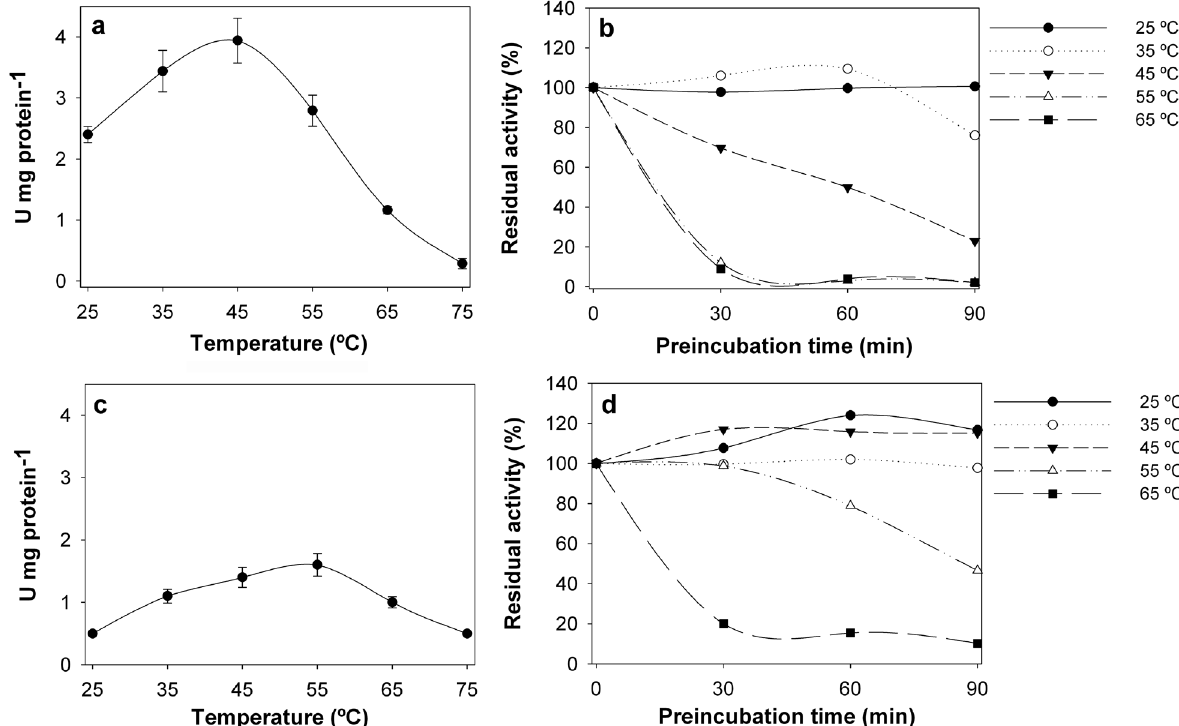
Fig. 2. Temperature effect on digestive proteases of juvenile of sheepshead Archosargus probatocephalus : (a) optimal tem- perature of acidic proteases, (b) temperature stability of acidic proteases, (c) optimal temperature of alkaline proteases, (d) temperature stability of alkaline